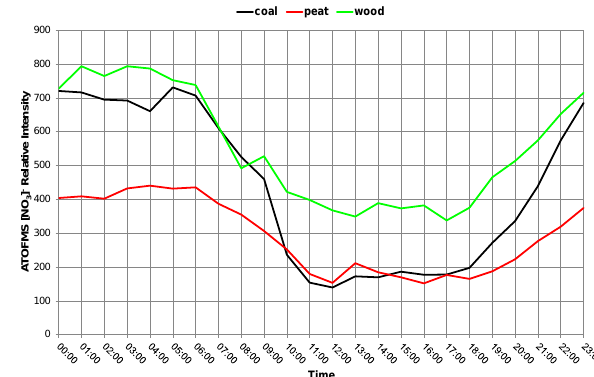
Fig. 9. Hourly averaged signal for nitrate for the Coal, Peat